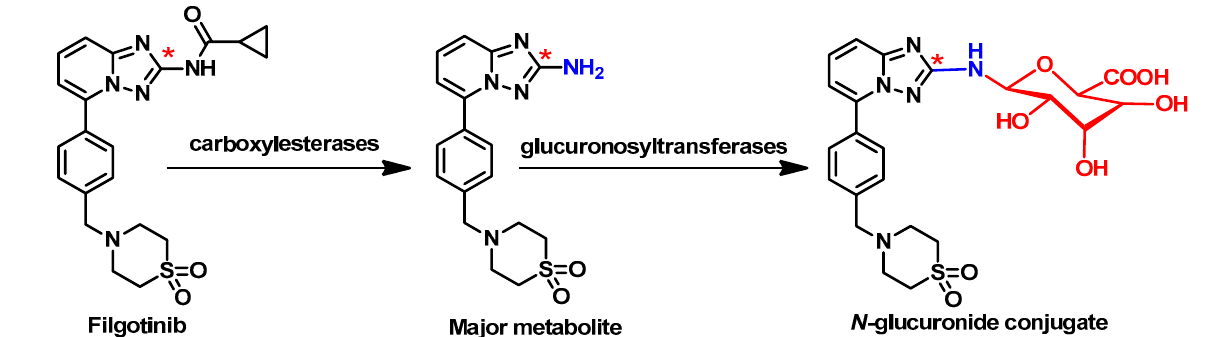
Figure 36. Proposed metabolic pathway of filgotinib.